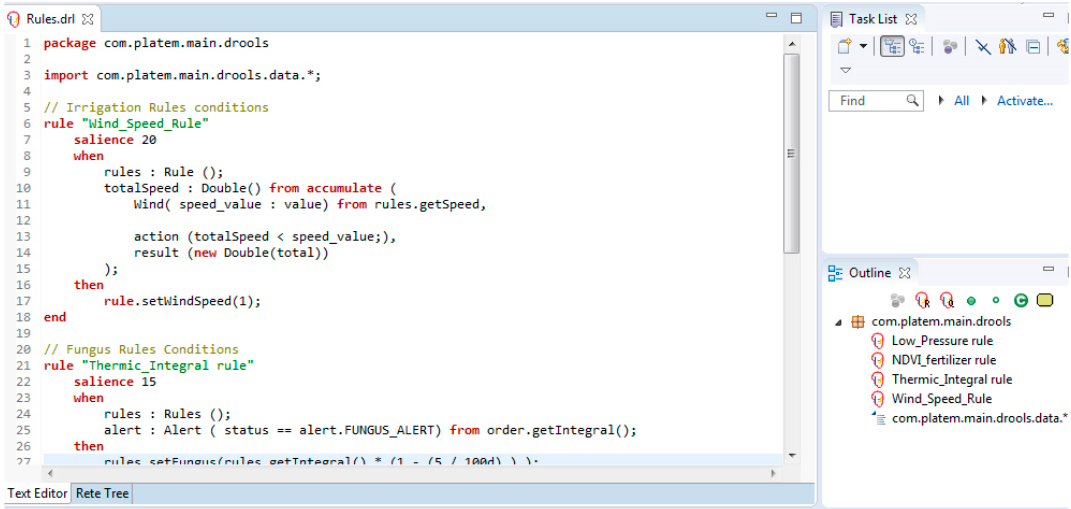
Figure 6. SDS verification rule definition.